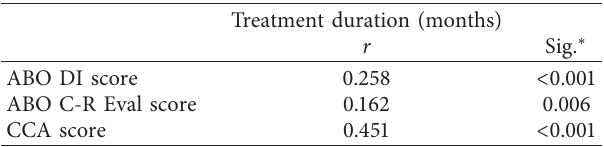
Table 6: Pearson correlation coefficients ( r ) between ABO DI, treatment outcomes, and treatment duration in